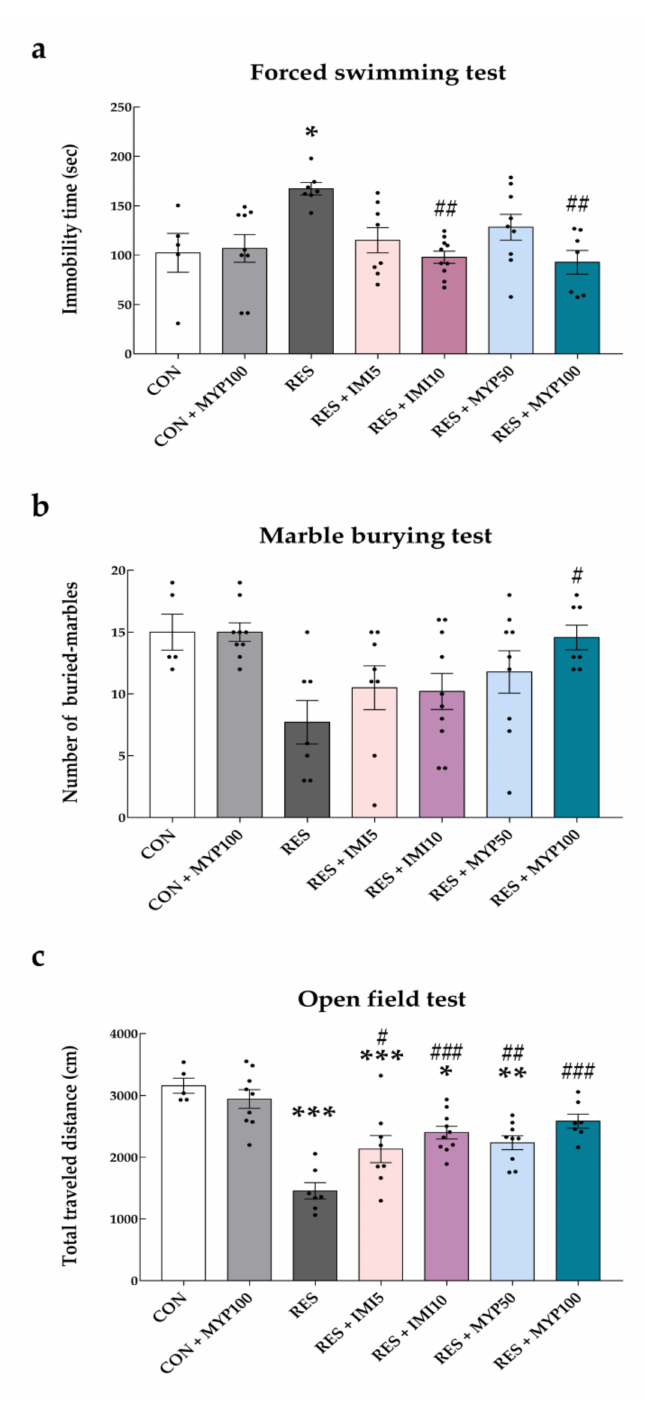
Figure 2. Improvement effects of myelophil (MYP) treatment on depression-like behaviors. Depression-like behaviors were evaluated using the forced swimming test ( a ), marble burying test ( b ), and open-field test ( c ) on day 22. High concentrations of MYP treatment significantly improved depression behaviors. CON: control ( n = 5), CON + MYP100: 100 mg/kg MYP treatment ( n = 9), RES: 2 mg/kg reserpine treatment ( n = 7), RES + IMI5: 2 mg/kg reserpine and 5 mg/kg imipramine treatment ( n = 8), RES + IMI10: 2 mg/kg reserpine and 10 mg/kg imipramine treatment ( n = 10), RES + MYP50: 2 mg/kg reserpine and 50 mg/kg MYP treatment ( n = 9), RES + MYP100: 2 mg/kg reserpine and 100 mg/kg MYP treatment ( n = 7). Data are expressed as the mean ± SEM. One- way ANOVA with Tukey post hoc tests was executed. * p < 0.05, ** p < 0.01, *** p < 0.001 vs. CON; # p < 0.05, ## p < 0.01, ### p < 0.001 vs.